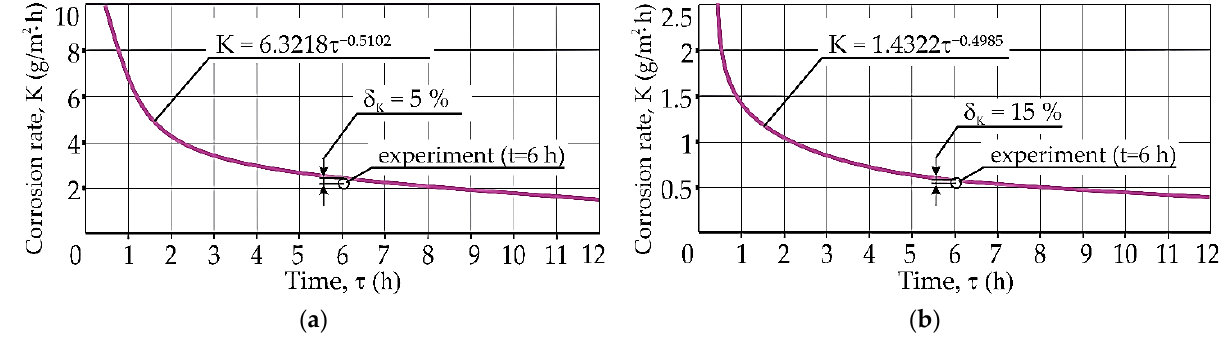
Figure 7. Dependences of the corrosion rate K on time of experiments τ under fuel oil (S r = 1.5%, α = 2.9, W r = 2%) ( a ) and WFE (S r = 1.5%, α = 2.9, W r = 30%) ( b ) combustion.